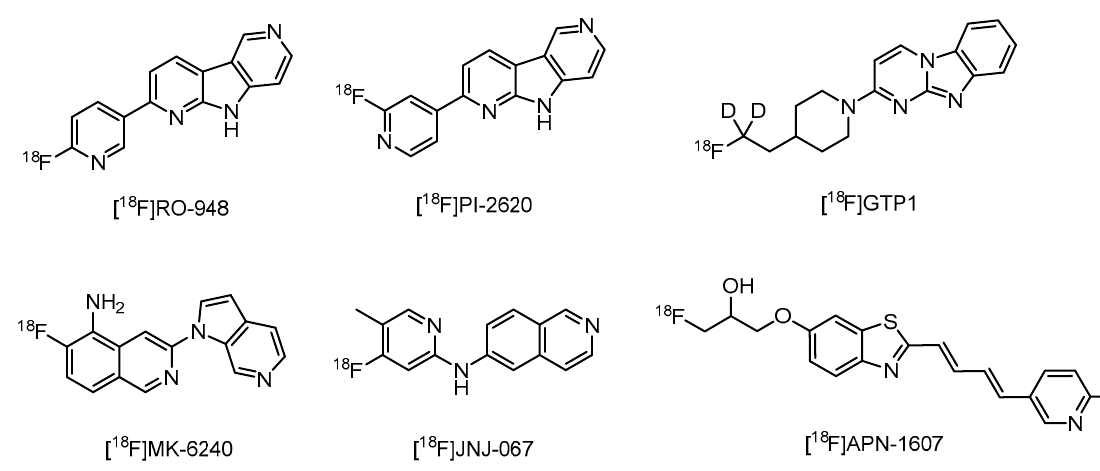
Figure 4. Structures of second-generation Tau PET tracers currently in clinical evaluation.